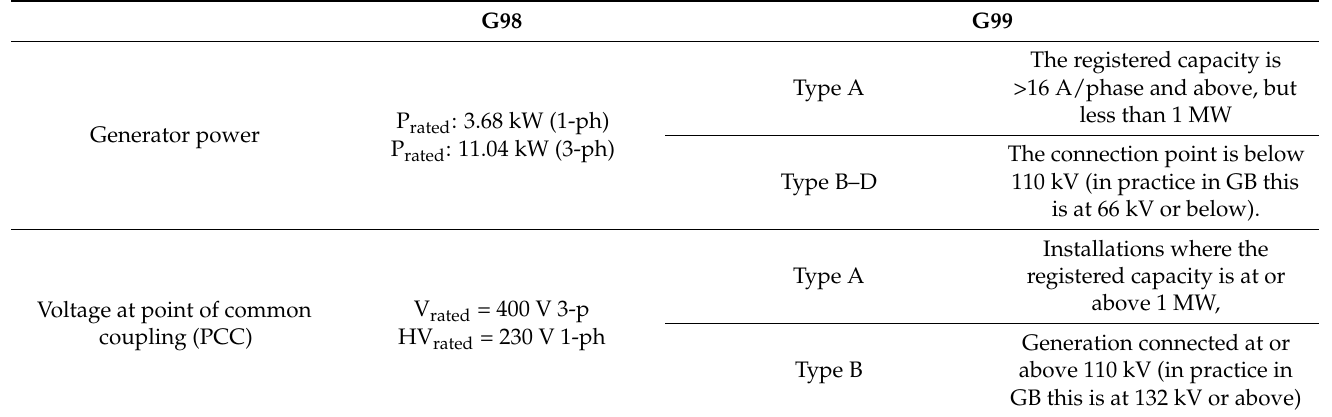
Table 3. EREC (UK) and the microgeneration connection requirements.